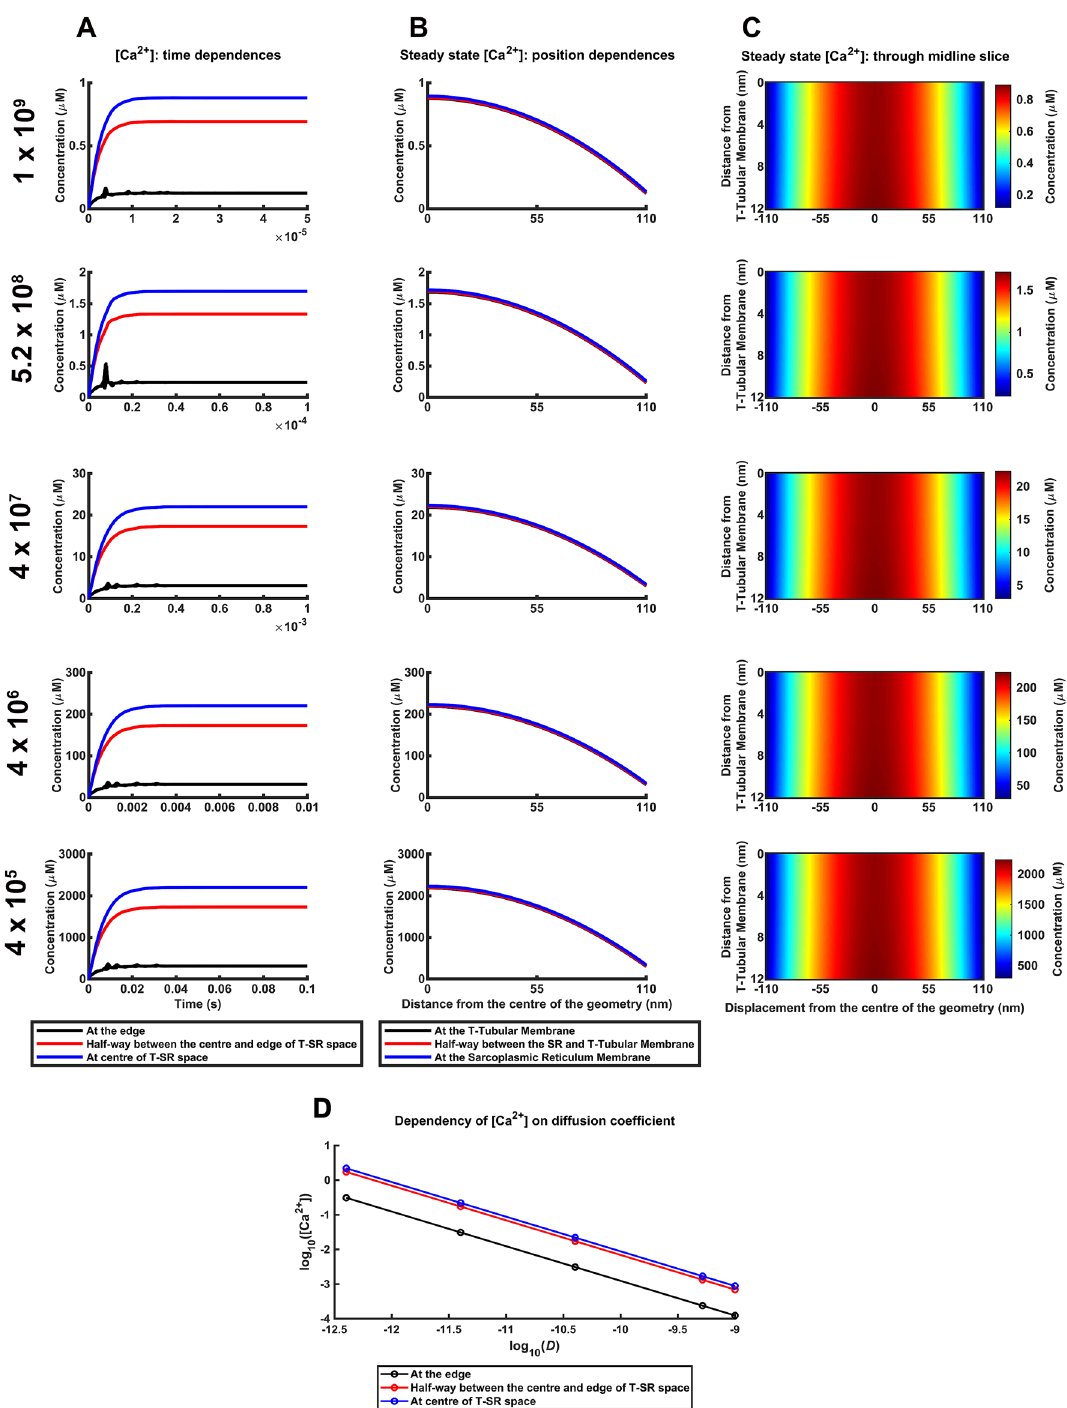
Figure 4. Ca 2+ microdomain characteristics persist with variation in Ca 2+ diffusion coefficient. (A-C) Exploring effects of variations in reported in vitro and in vivo Ca 2+ diffusion coefficient values (units: nm 2 /s), D , ranging from highest reported values at infinite dilution, through two reported in vivo values, and two substantially lower values for comparison. Ca 2+ influx density, J influx , T-SR diameter, d , and T-SR distance, w , maintained constant at values adopted in the T-SR model (Table 1). ( A ) Variations in [Ca 2+ ] with time following onset of imposed J influx . ( B ) Dependence of the resulting steady state [Ca 2+ ] with radial distance from the centre of the T-SR junction. ( C ) Mapping of [Ca 2+ ] across a midline axial slice; values of [Ca 2+ ] scaled linearly with maximum [Ca 2+ ] at centre of T-SR junction to illustrate features of microdomain characteristics and radial concentration gradients. ( D ) Inverse relationship between [Ca 2+ ] at the centre, the edge, and halfway between these of the T-SR junction, and diffusion coefficient, D . Linear double logarithmic plots of [Ca 2+ ] TSR centre , [Ca 2+ ] TSR 50% and [Ca 2+ ] TSR edge , against diffusion coefficient, D , coefficients corresponding to an inverse relationship between [Ca 2+ ] TSR centre , [Ca 2+ ] TSR 50% and [Ca 2+ ] TSR edge , and D , at constant Ca 2+ influx density, J influx , T-SR diameter, d , and T-SR distance, w